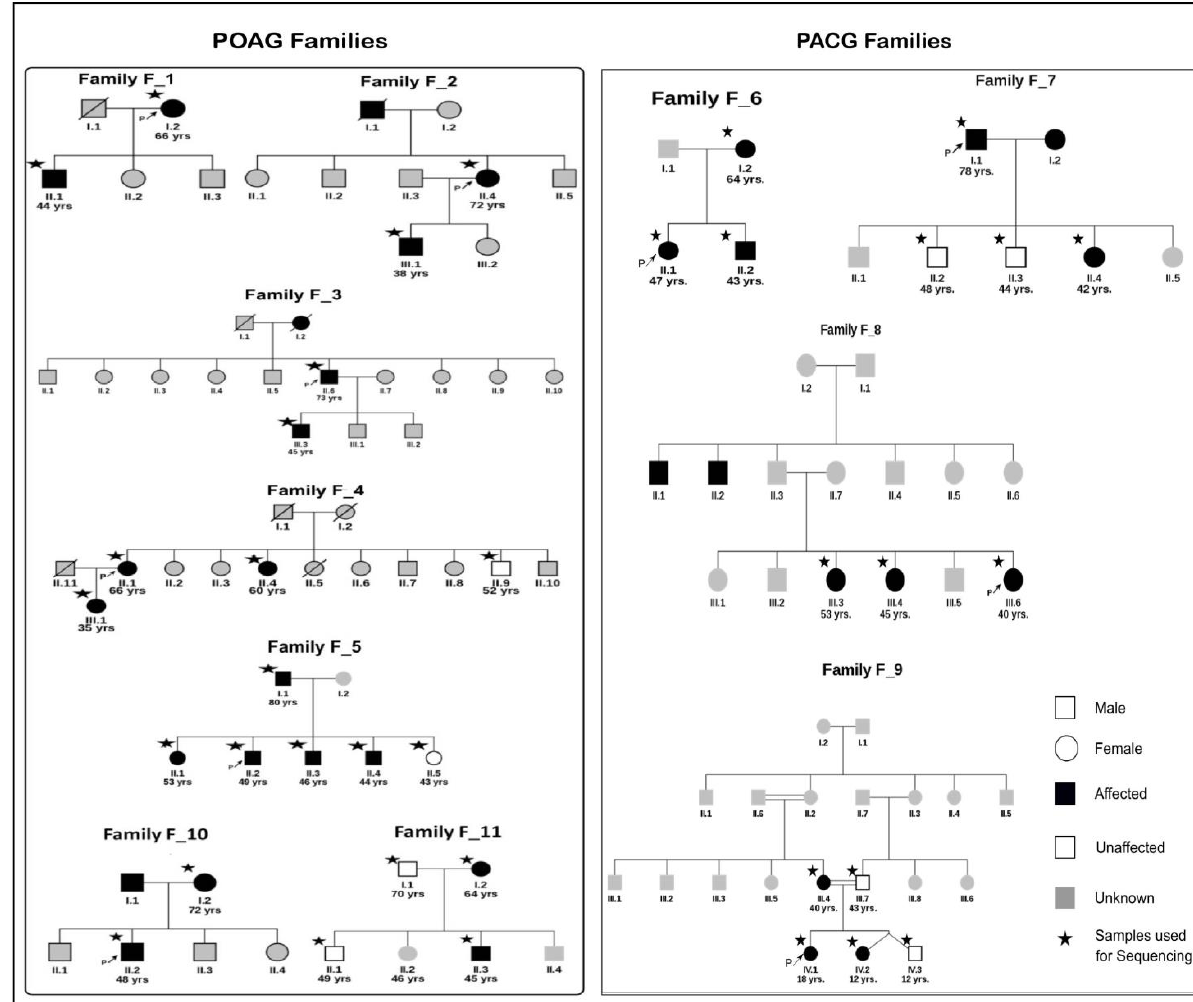
Figure 2. The pedigrees of seven POAG families and four PACG families used for exome se- quencing. All individuals in white symbols have tested negative for glaucoma. The individuals in gray represent members with disease status unknown. Other symbols represent usual pedigree no- menclature. The arrow represents the proband and star * indicates the samples used for exome se- quencing (Except families F_10 and F_11 were not exome sequenced as they had known MYOC mutations).